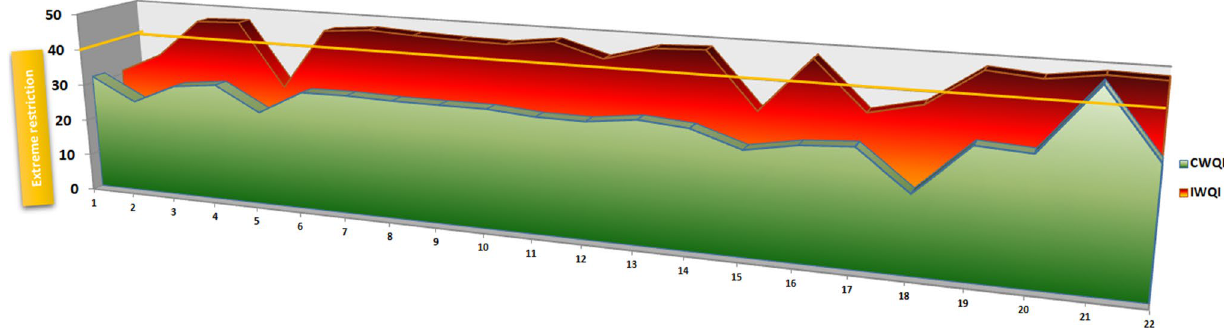
Fig. 7 Distribution of CWQI and IWQI